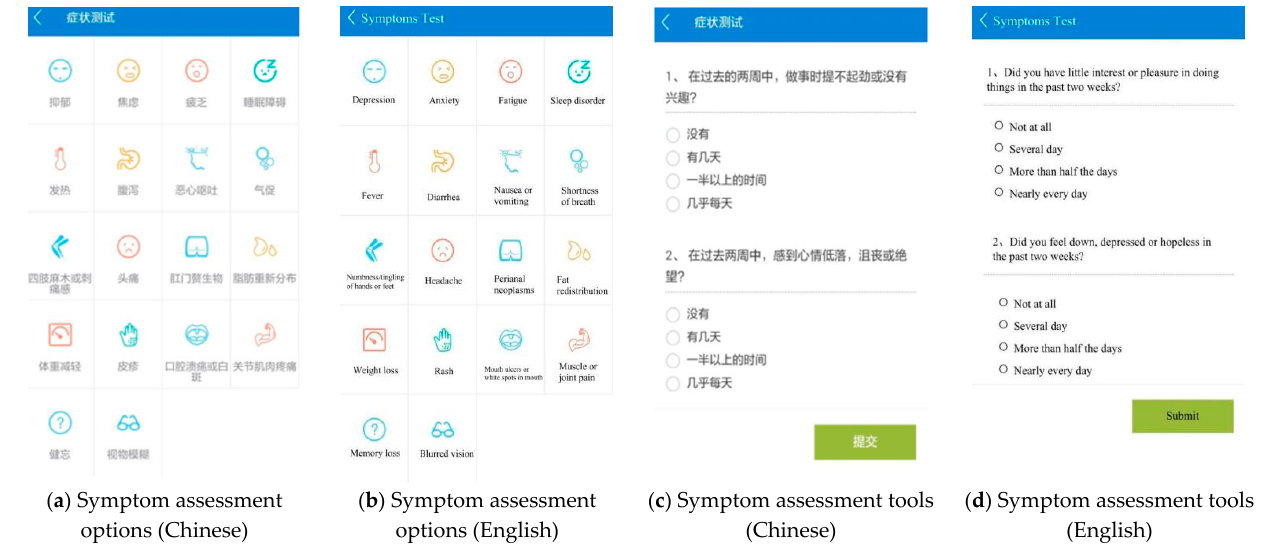
Figure 4. Screenshot of symptom assessment options and symptom assessment tools. A total of 80 symptom management strategies are available in the SM app. Users receive personalized result interpretations and strategies (Figure 5a) according to their assessment submission and cutoffs. Appendix 3 also presents all the cutoffs for each assessment tool.